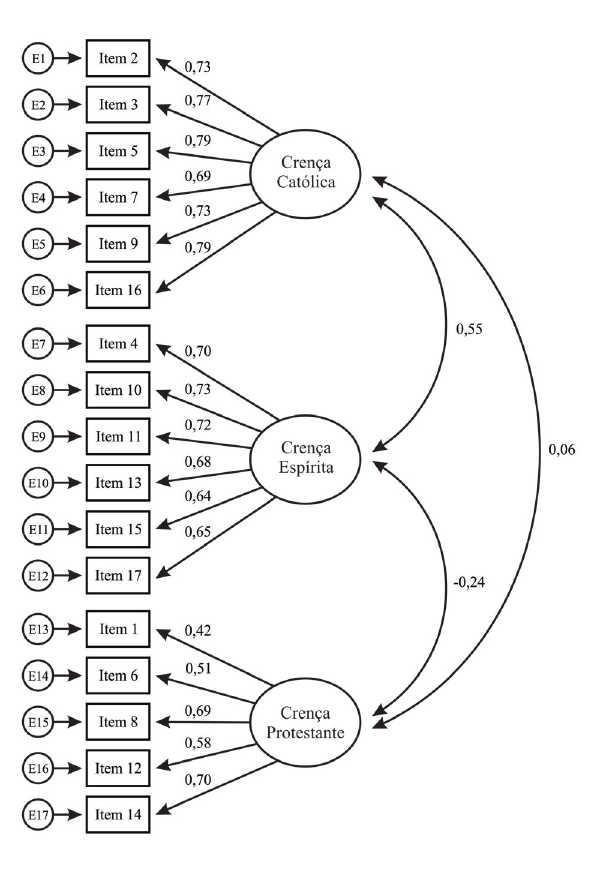
Figura 1 . Estrutura multifatorial da Escala de Crenças Reli-